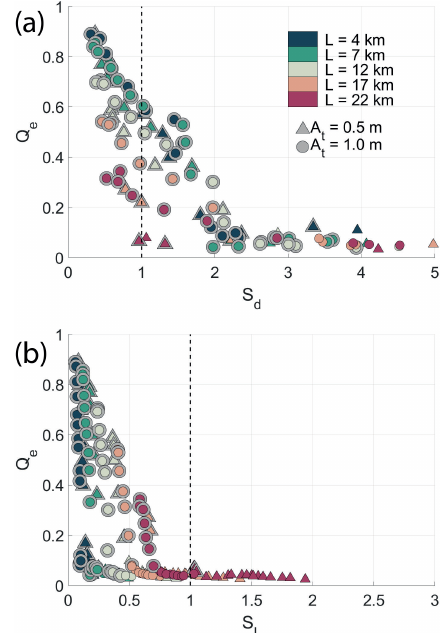
Figure 17. The effective transport, Q e , plotted against the nondi- mensional parameters (a) S d and (b) S L . Dipoles, recognized from the criteria given in Sect. 5, are marked with a gray